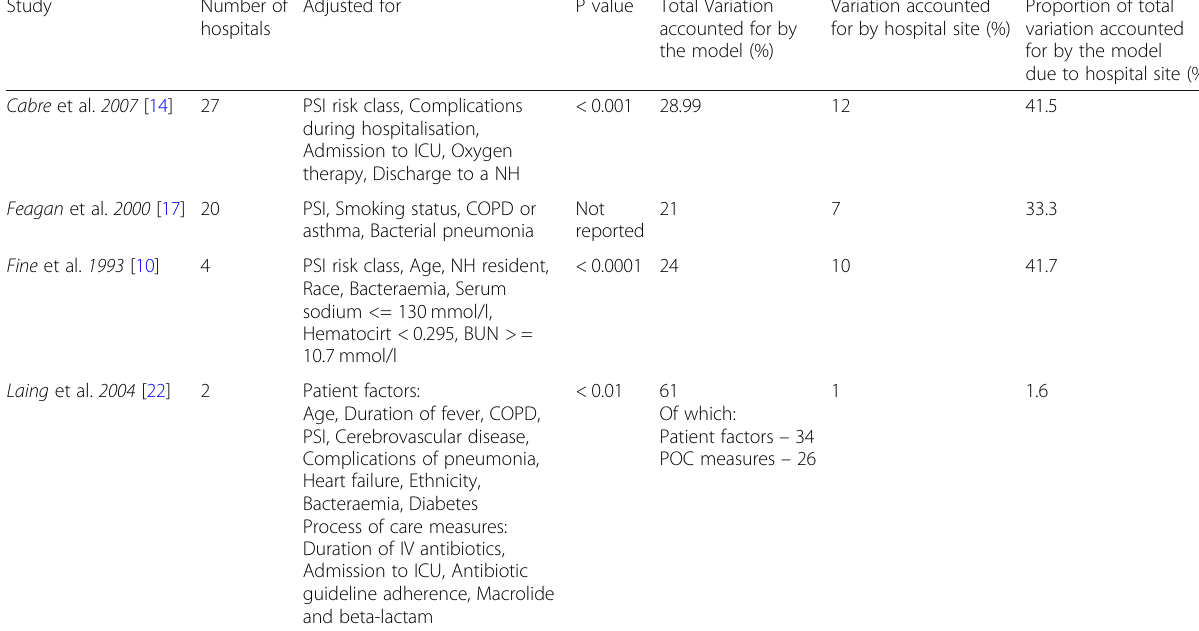
Table 2 Contribution of hospital of admission to Variation in Length of Stay